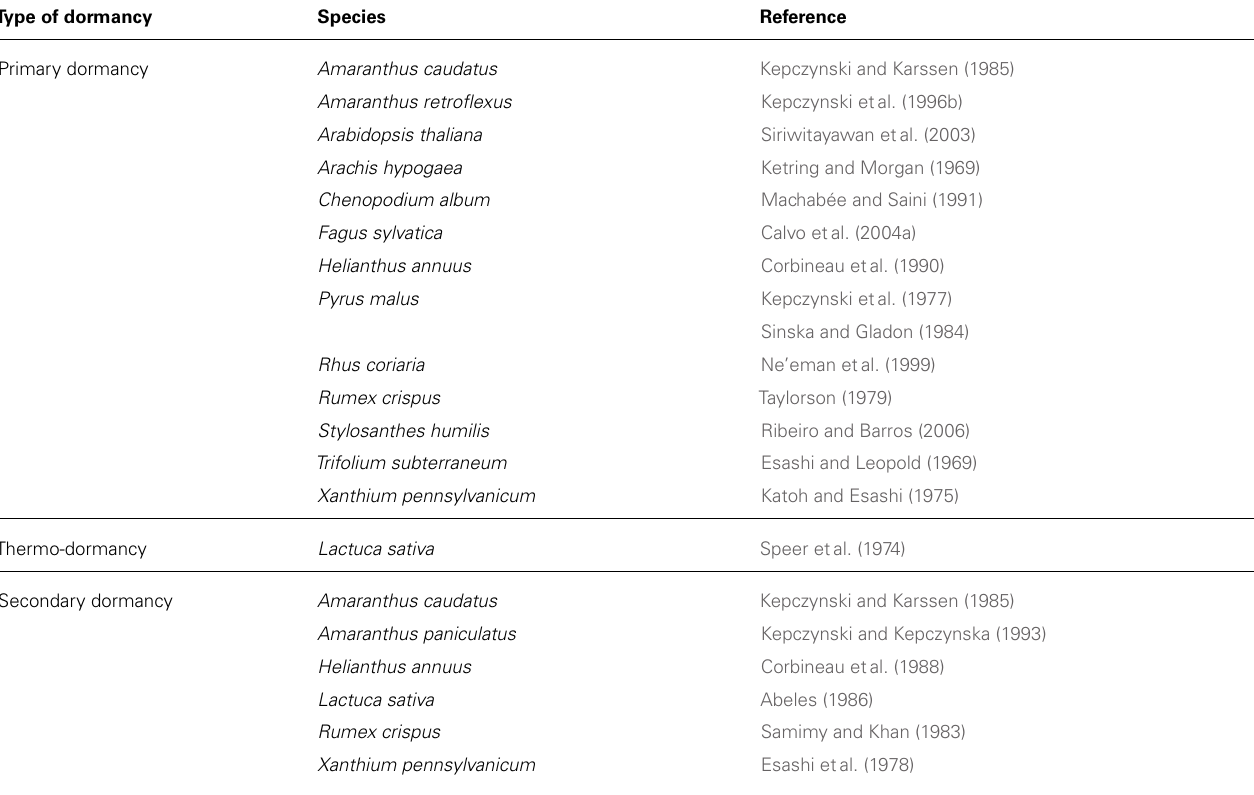
Table 1 | Plant species whose seed dormancy is broken by ethylene, ethephon, an ethylene releasing compound, or 1-aminocyclopropane- 1-carboxylic acid, the direct precursor of